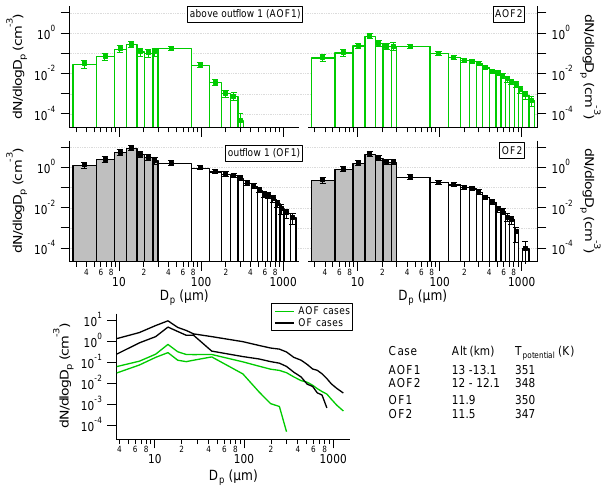
Fig. 4. Time series segment of the MCS anvil and outflow cloud crossing during descent on 7 August 2006. The shadings indicate time periods which were selected for deriving the ice particle size distributions as displayed in Fig. 5. ( N 6 − 15 denotes the concentra- tion difference N 6 − N 15 .)